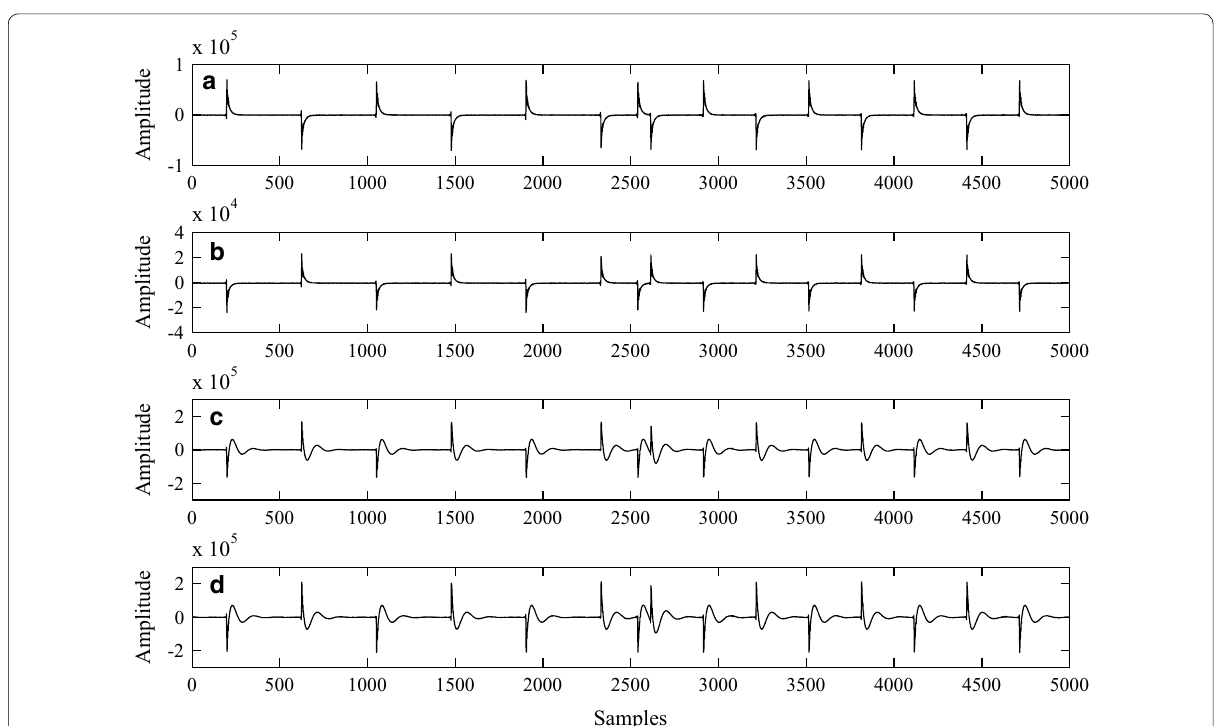
Fig. 3 Raw time-series segments from the data set D 2 of the station ASY0002B, a sampling rate of 150 Hz. a Ex component; b Ey component; c Hx component; d Hy